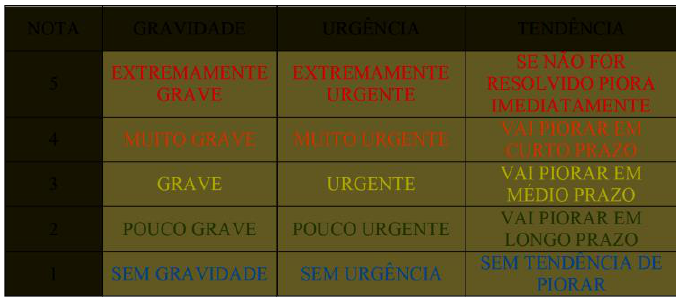
Tabela 5: Referência de Notas.